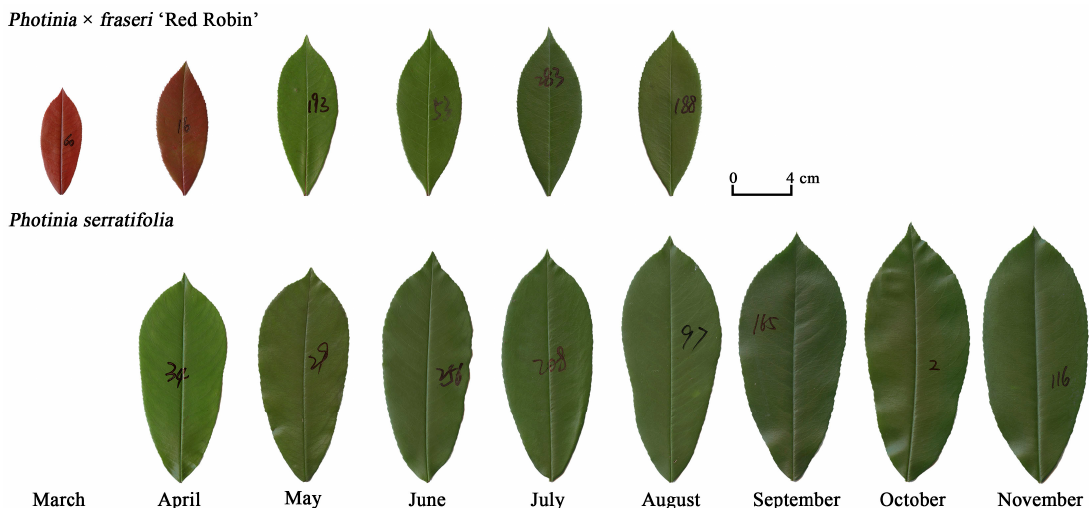
Figure 1. Representative leaves for the two Photinia taxa (the hybrid P. × fraseri and one of its parents P. serratifolia ) at different times in the growing season during 2021.